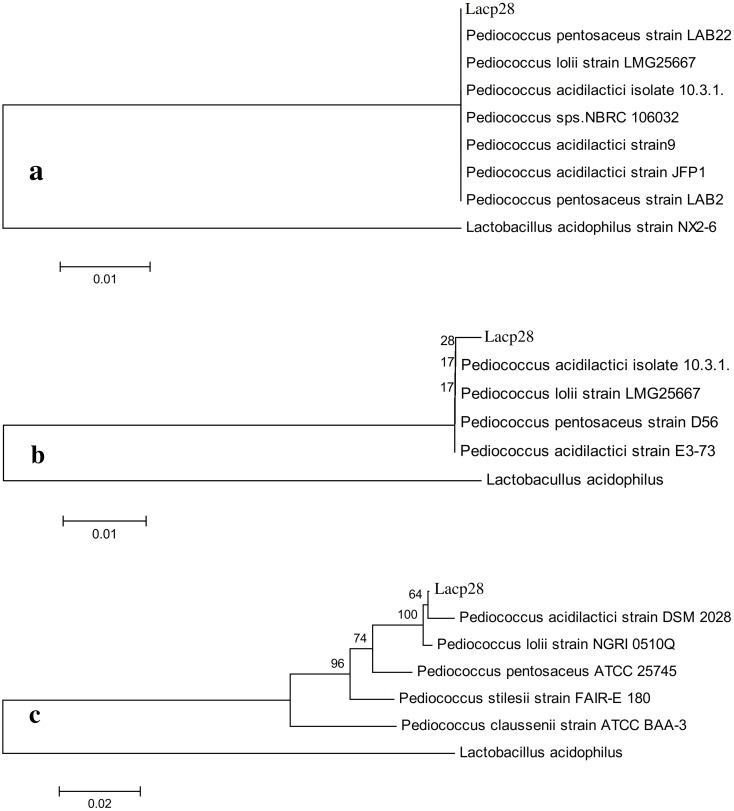
Phylogenetic tree prepared by Clustal V method for molecular identification of Lacp28 with different primers a) 27F/1492R; b) LpigF/LpigR and c) S-17F/ A-17R.